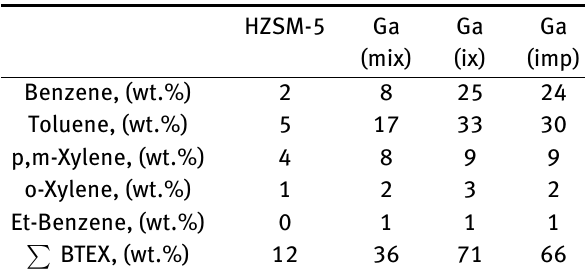
HZSM-5 Ga Ga (mix) (ix)